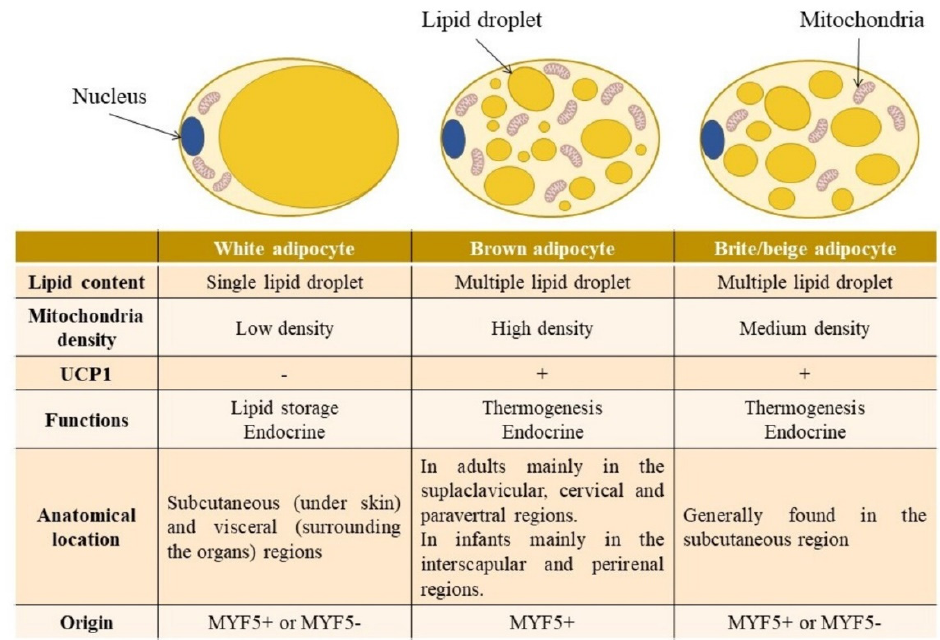
Figure 1. Differences in the metabolic characteristics, functions, anatomical location and origin be- tween white, brown and beige adipocytes. UCP1: uncoupling protein 1; MYF5: myogenic regulatory factor 5.